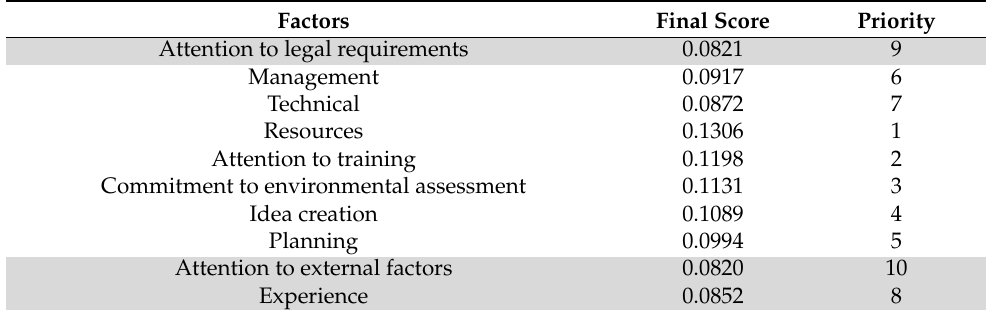
Table 4. The priority of effective managerial factors and indicators in the improvement and renovation of the old tissues of the city.